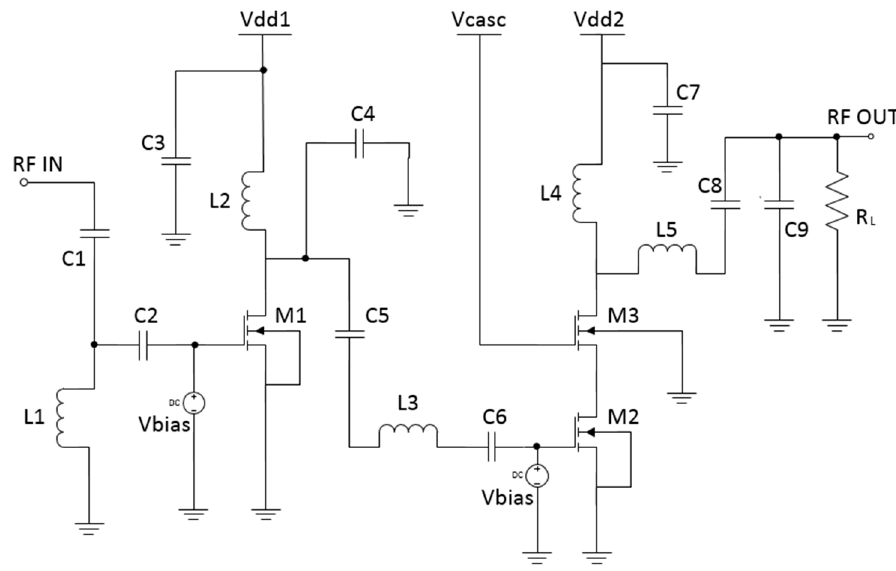
Figure 5. Cascode-modulated CMOS PA